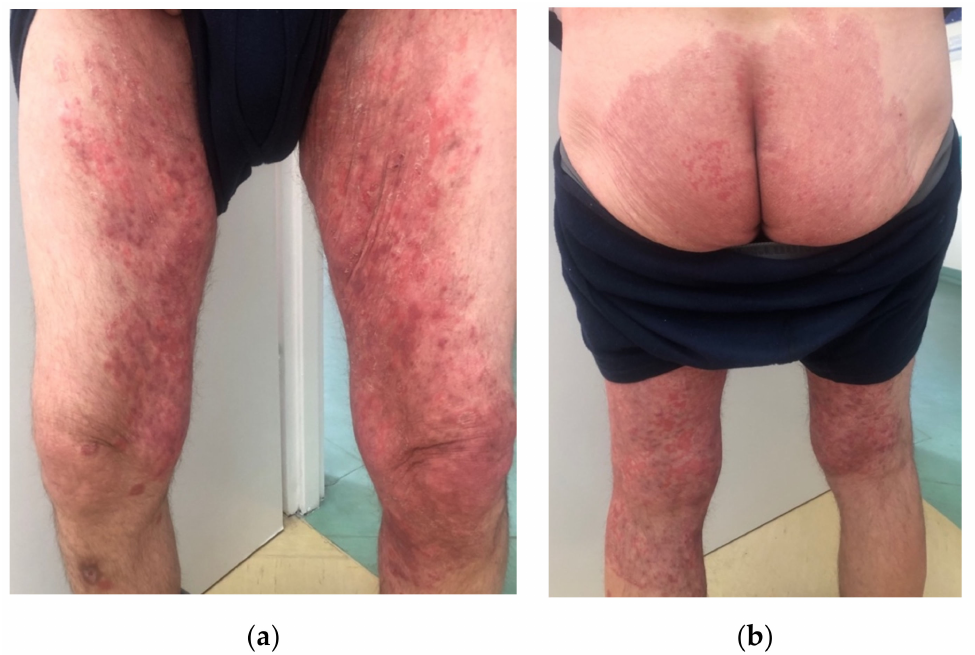
Figure 1. At admission. Erythematous–infiltrative lesions with pustules in the medial and posterior area of both thighs and groins ( a ), erythematous–exfoliative lesions on the buttocks ( b